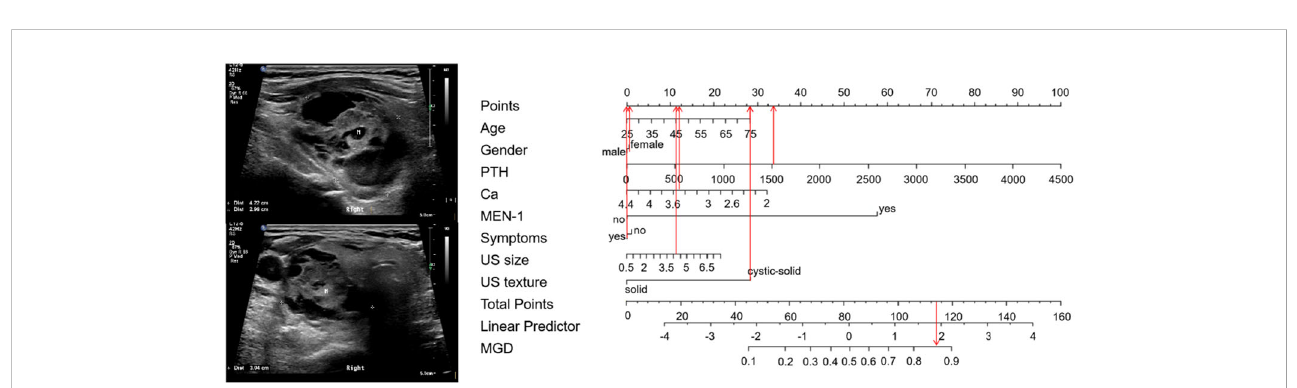
FIGURE 4 Examples of clinical use the nomogram for MGD. A75-year-old woman with PHPT complained bone pain in both lower extremities. The PTH and serum calcium level were 1526 pg/ml and 3.45 mmol/L respectively. MEN-1 was not diagnosed. The neck ultrasound showed cystic-solid nodule with 4.2cm in size in the posterior aspect of her right thyroid. The total score is 117, which corresponds to an MGD risk of greater than 0.85. Pathology con fi rmed that there were two glandular involved (an adenoma with cystic degeneration on the right side, and a hyperplasia on the left side), with an adenoma and a hyperplasia. M, mass.